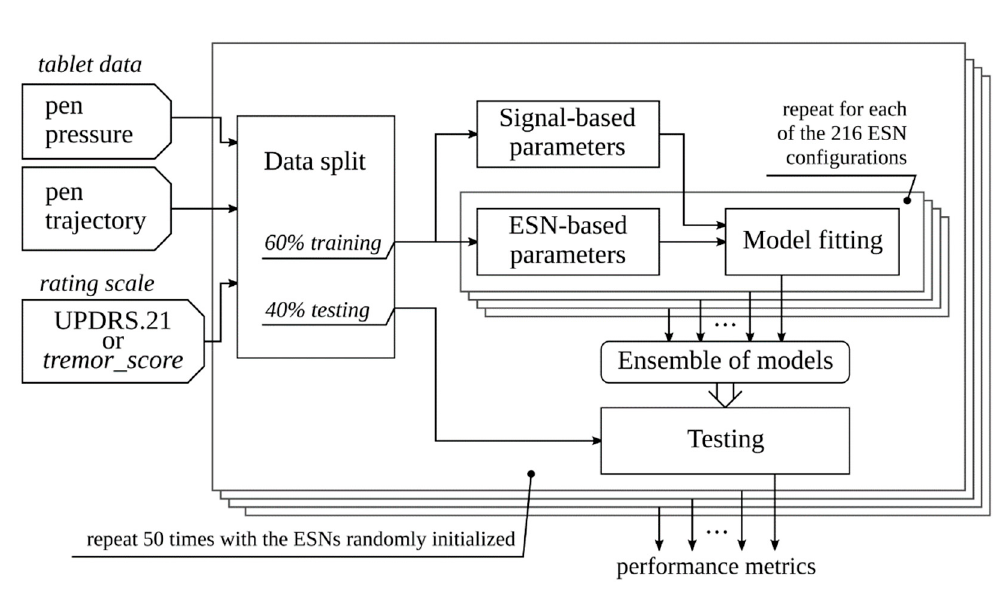
Figure 3. The diagram of the process of training and testing ensembles of models. The ensembles are formed and tested 50-fold. In each fold: (1) the ESNs used for computation of parameters are randomly reinitialized, and (2) the signal-based parameters are reused during model fitting while the ESN-based parameters are computed separately for each of the configurations considered.